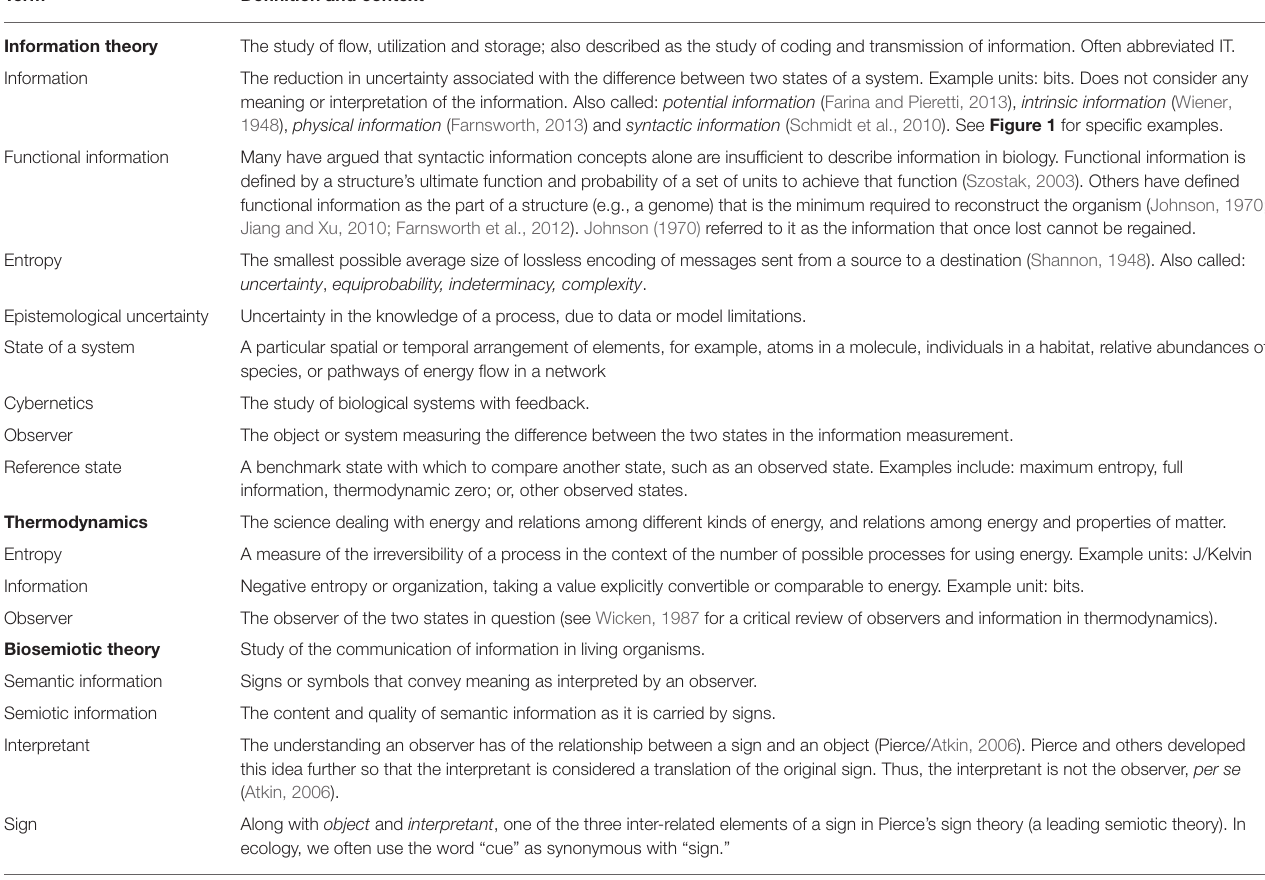
TABLE 1 | Glossary for general terms and